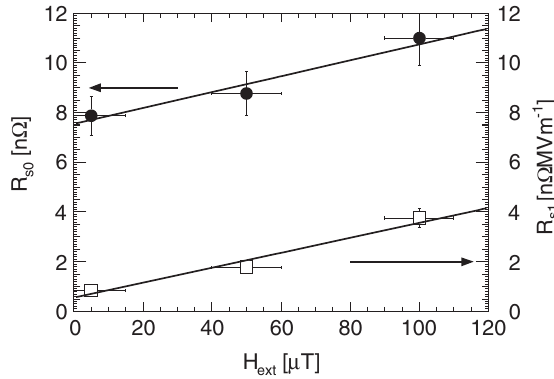
FIG. 5. Residual surface resistances as a function of the trapped magnetic field. The circles show R